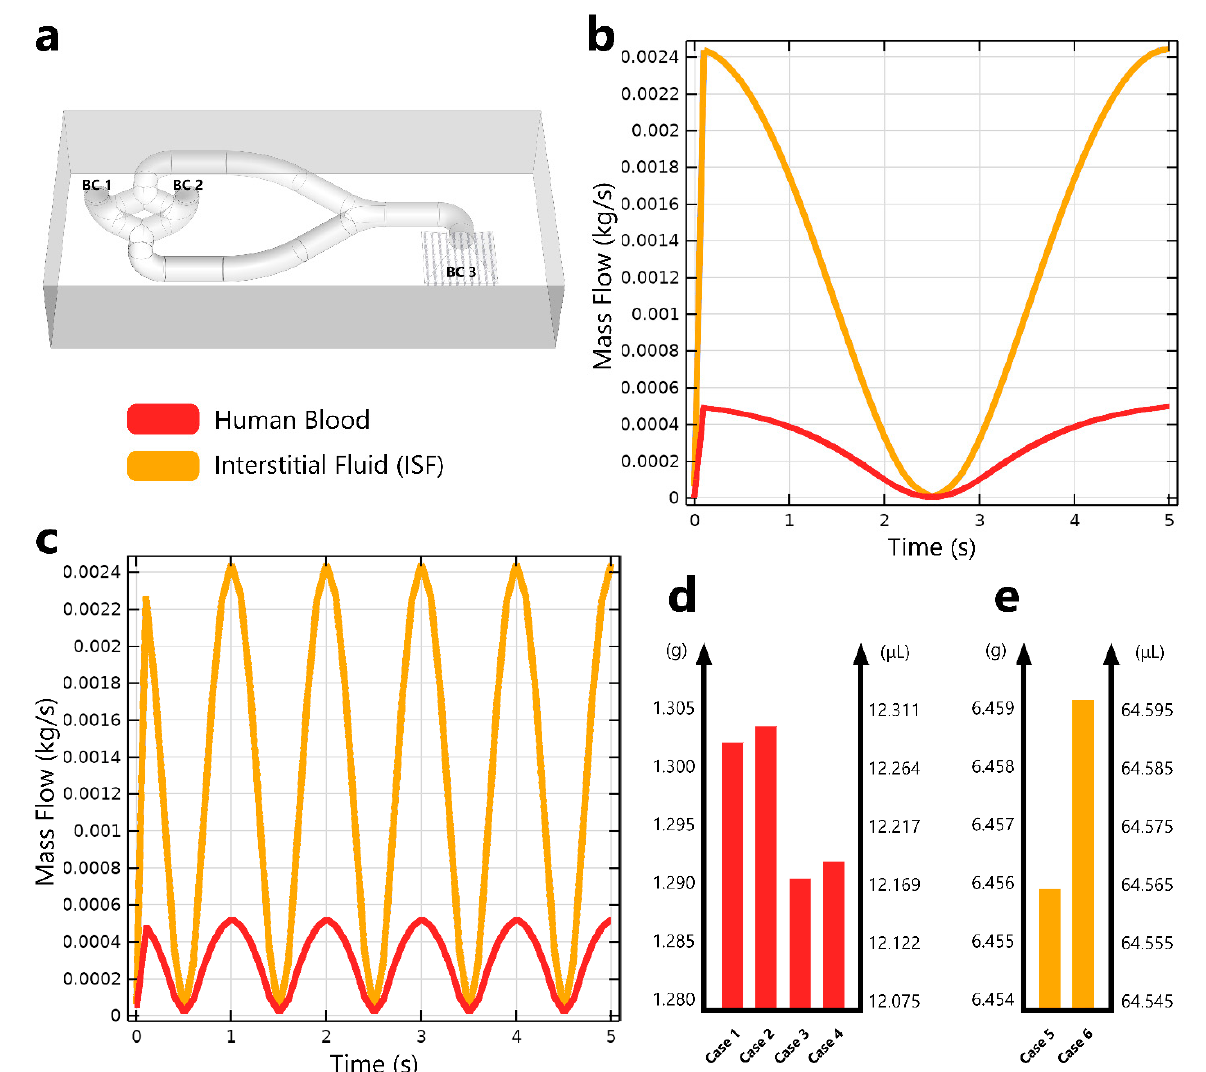
Figure 4. Mass flow-time curves at the reservoir and fluid extraction efficiency results. Two different fluids, human blood and interstitial fluid (ISF), with various boundary conditions (BCs) were used for simulation, which created a total of 6 different cases (organized in Table 3). ( a ) Representation of the device, and the referrals to the defined BCs. ( b ) The mass flow curve result at the reservoir for case 1 and case 5, presented in red and yellow, respectively. ( c ) The mass flow curve result at the reservoir for case 2 and case 6, presented in red and yellow, respectively. The curves at ( b , c ) show the mass flow rate in kg.s − 1 for time in seconds for a duration of 5 s. ( d ) Amounts of human blood extraction (cases 1 to 4), with the left vertical axis representing the total amount of the extracted human blood in grams, over a duration of 5 s, and the right vertical axis representing the average amount of human blood extraction for each needle in microliters (µL) over a duration of 5 s. ( e ) Amounts of ISF extraction (cases 5 and 6), with the left vertical axis representing the total amount of the extracted ISF in grams over a duration of 5 s, and the right vertical axis representing the average amount of ISF extraction for each needle in microliters (µL) over a duration of 5 s.